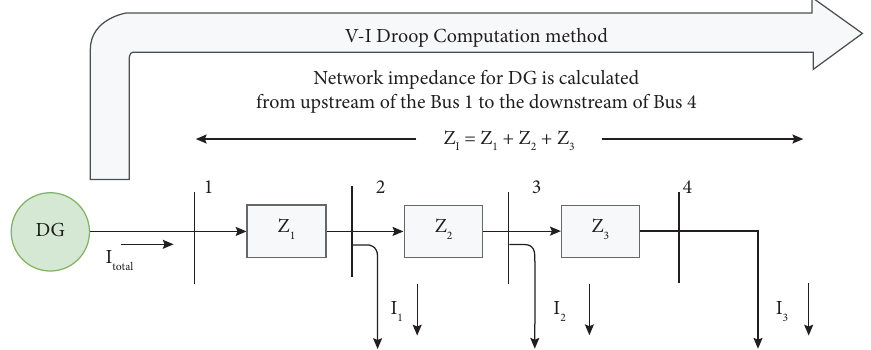
Figure 1: Conventional method of droop estimation [24].